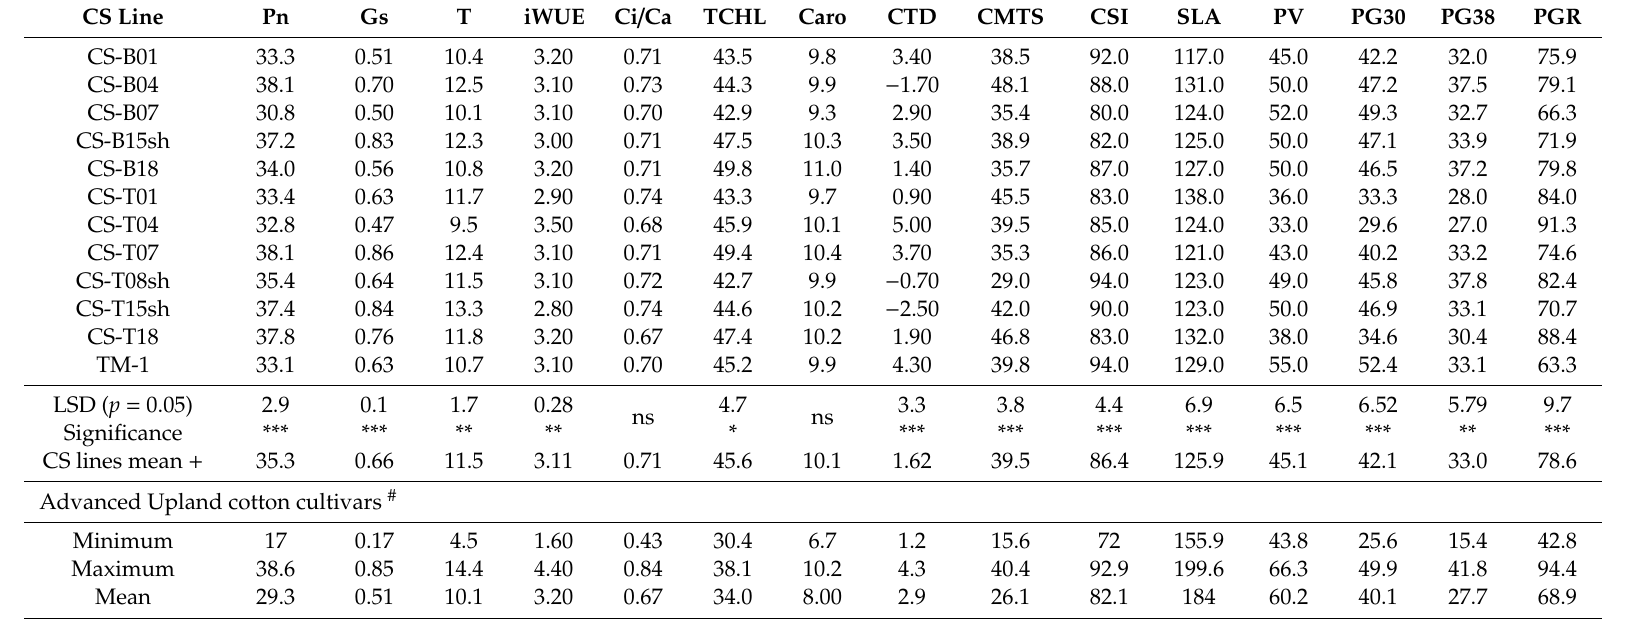
Table 1. Leaf gas exchange (Pn—photosynthesis, µ mol m − 2 s − 1 ; Gs—stomatal conductance, mol m − 2 s − 1 ; T—transpiration, mmol H 2 O m − 2 s − 1 ,